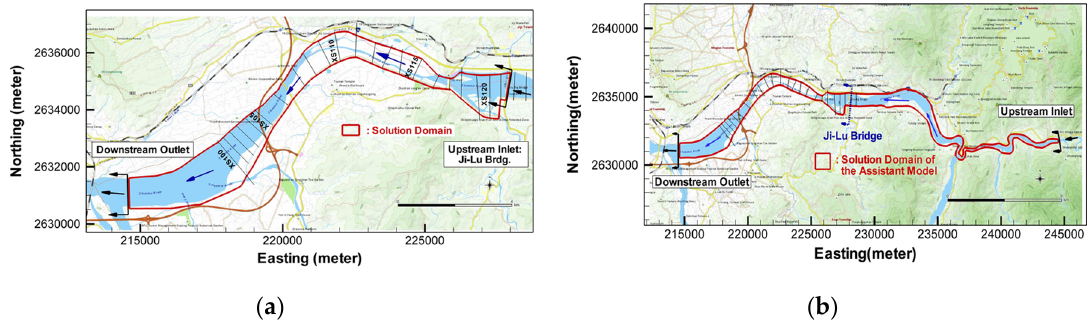
Figure 5. The solution domains of the primary model and the assistance model (background map source: maps.nlsc.gov.tw web map service). ( a ) The primary model; ( b ) The assistance model.